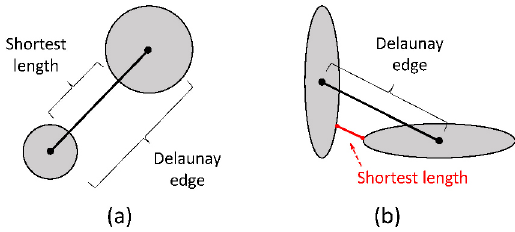
Fig. 21 Shortest length between: (a) two circles, (b) two